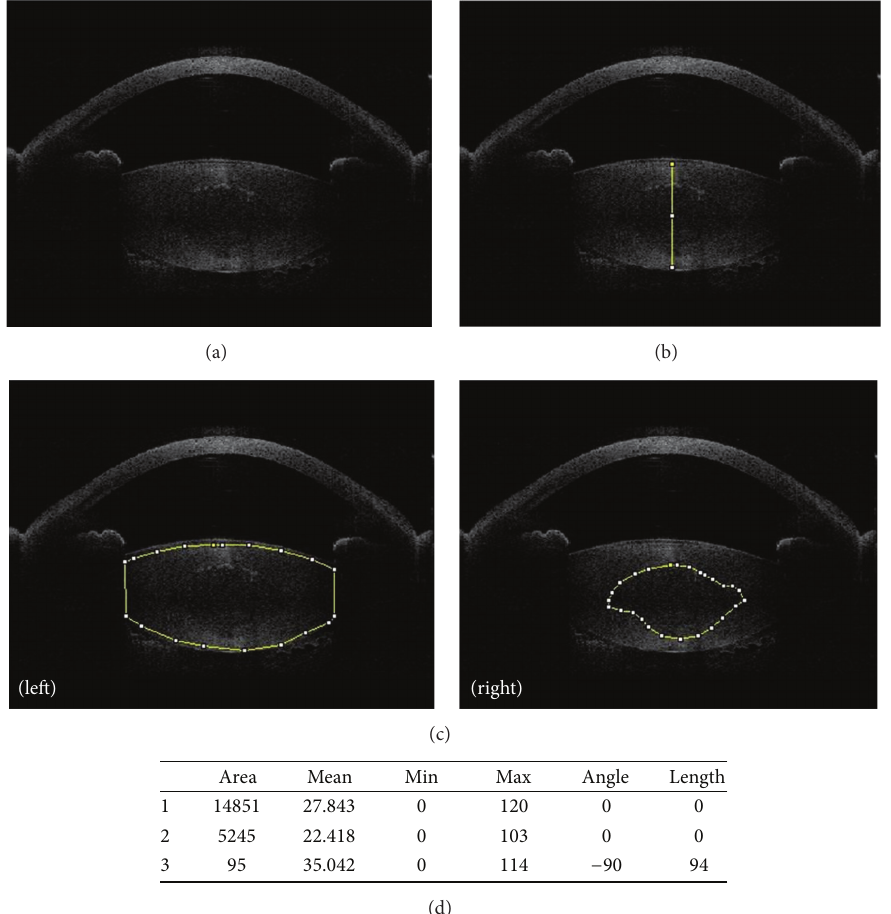
Figure 1: The procedure for measuring lens opacity, lens nuclear density, and lens thickness using ImageJ program. (a) A CATALYS OCT image of anterior segment including entire lens. (b) The procedure for measuring lens thickness from the image. (c) The procedure for measuring whole lens density (left) and nuclear density (right). (d) Lens density and lens thickness values measured using ImageJ (pixel intensity unit). Table 2: Demographic data and Lens Opacities Classification System (LOCS) III cataract grading.